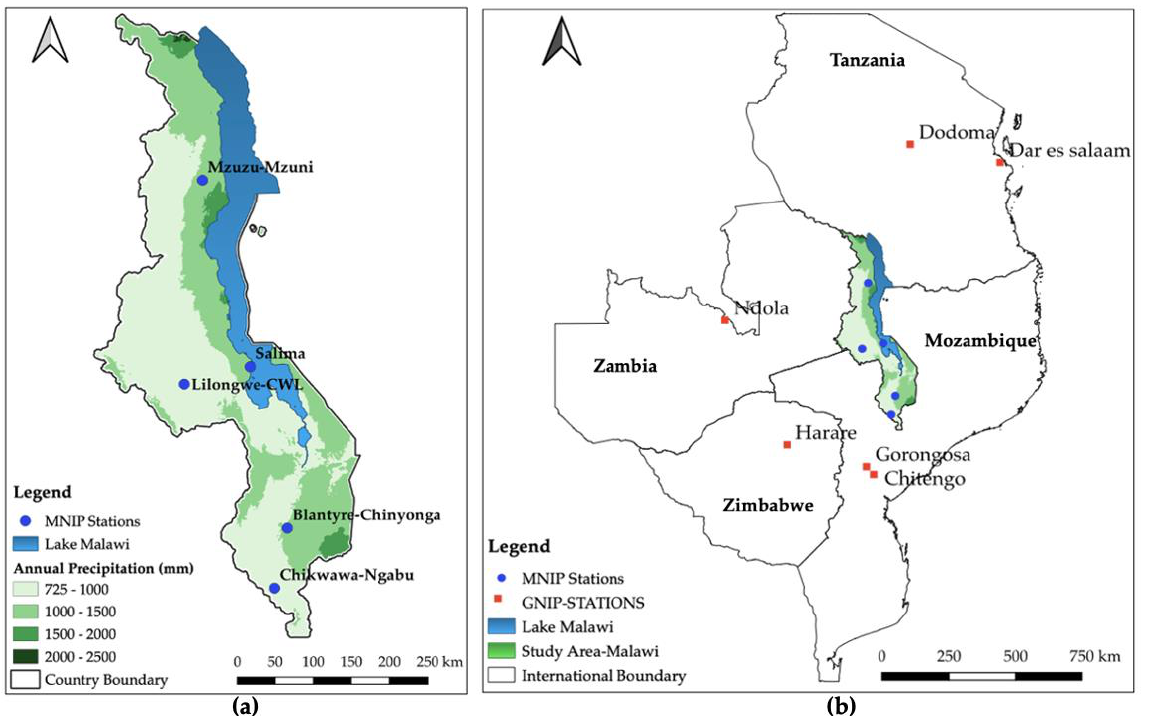
Figure 2. Malawi – network of isotopes in precipitation (MNIP) stations ( a ) and global network of isotopes in precipitation (GNIP) stations ( b ). Table 1. Summary of isotopic sampling undertaken from Malawi Network of Iso – topes in Precipi- tation (MNIP) Stations (1914 – 2019).